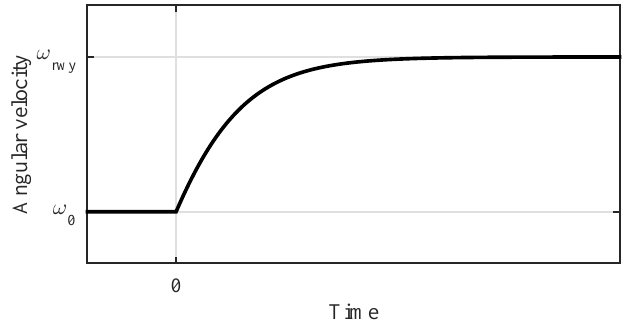
Figure 1. Example of angular velocity development according to the analytical